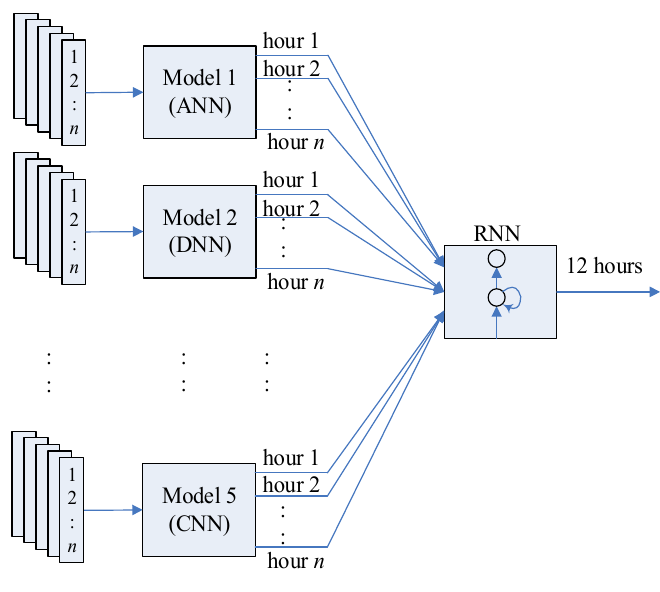
Figure 2. The proposed RNN-based ensemble method. Figure 1. Stacking